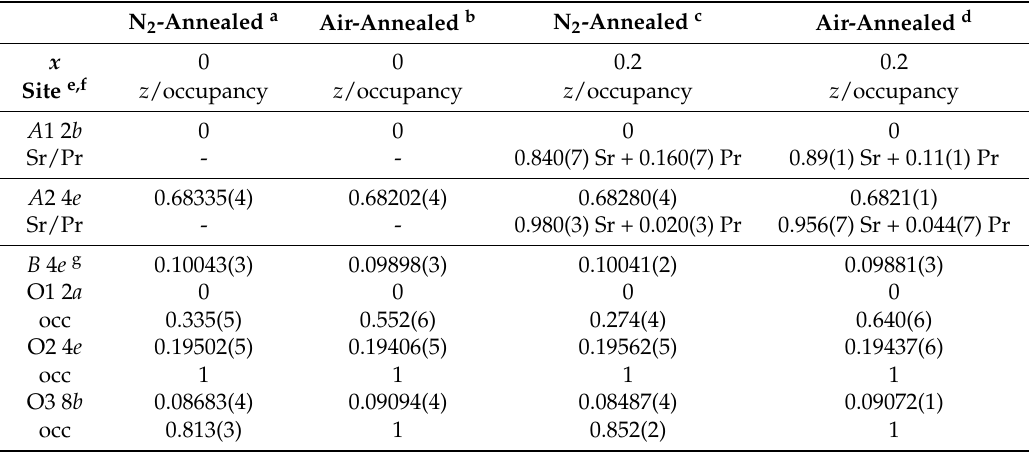
Table 1. Refined structural parameters for as-prepared in N 2 and air-annealed x = 0.0 and